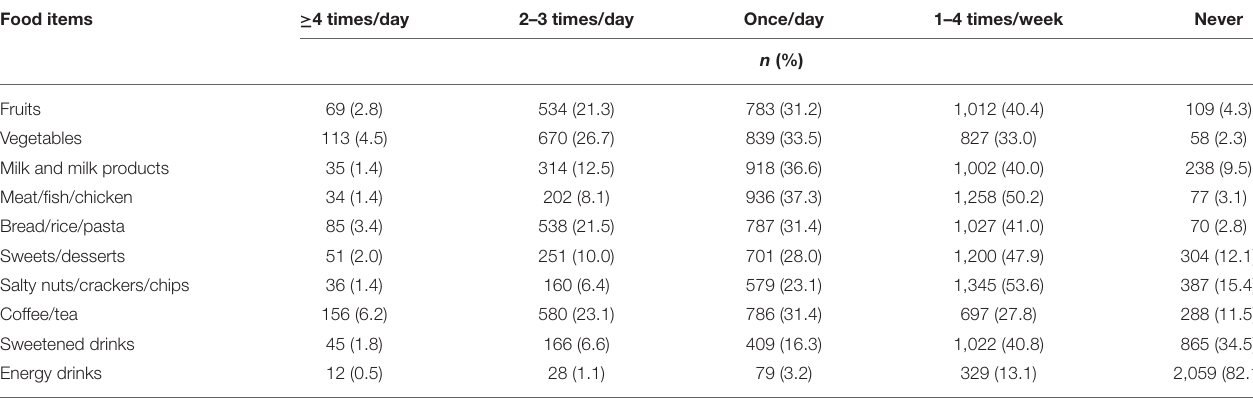
TABLE 4 | The frequency of consumption of certain foods during the COVID-19 pandemic ( n = 2,507). Food items